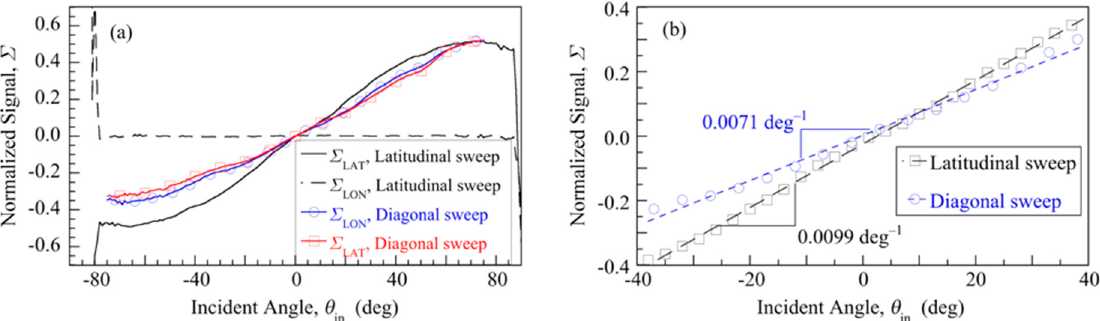
Figure 4. ( a ) Normalized signals for a latitudinal sweep (black solid and dashed lines) and a diagonal sweep (red and blue symbols and lines). ( b ) Details of the -40° to 40° portion of (a). Dashed lines are linear fits to the data, with linear slopes indicated.